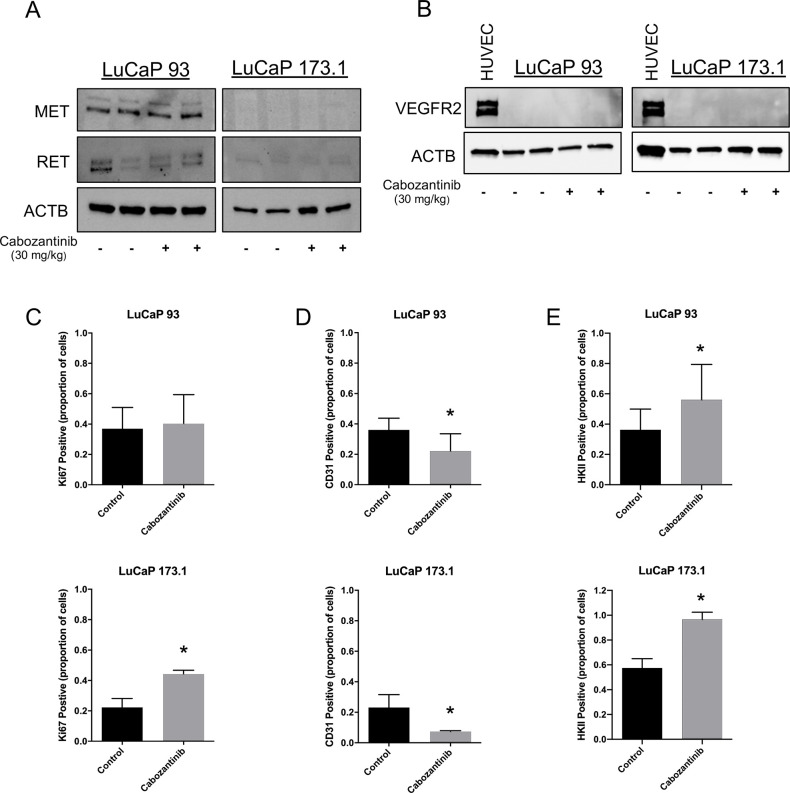
Cabozantinib treatment decreased microvessel density, but not proliferation and increased hypoxic stress in LuCaP 93 and LuCaP 173.1 patient-derived xenografts.(A) Immunoblots of tumor lysates from LuCaP 93 and LuCaP 173.1 in vivo study tumors. Blots were probed with primary antibodies to MET, RET and ACTB. (B) Immunoblots of HUVEC cells and tumor lysates from LuCaP 93 and LuCaP 173.1 in vivo study tumors. HUVEC cell lysates were used as a positive control and blots were probed with primary antibodies to VEGFR2 and ACTB. (C) Graphs of Ki67 positive cells in control vehicle and cabozantinib-treated LuCaP 93 (p = 0.63, top graph) and 173.1 (p<0.001, bottom graph)* tumors. (D) Graphs of CD31 positive cells in control vehicle and cabozantinib-treated LuCaP 93 (p = 0.001; top graph) and LuCaP 173.1 (p = 0.01; bottom graph) tumors. (E) Graphs of Hexokinase II positive cells in control vehicle and cabozantinib-treated LuCaP 93 (p = 0.0184; top graph) and LuCaP 173.1 (p<0.001; bottom graph) tumors. Results are plotted as mean ± SD. *The cabozantinib-treated group in the LuCaP 173.1 study had only 3 tumors that could be assessed as the remaining tumors were too necrotic or too small to assess.